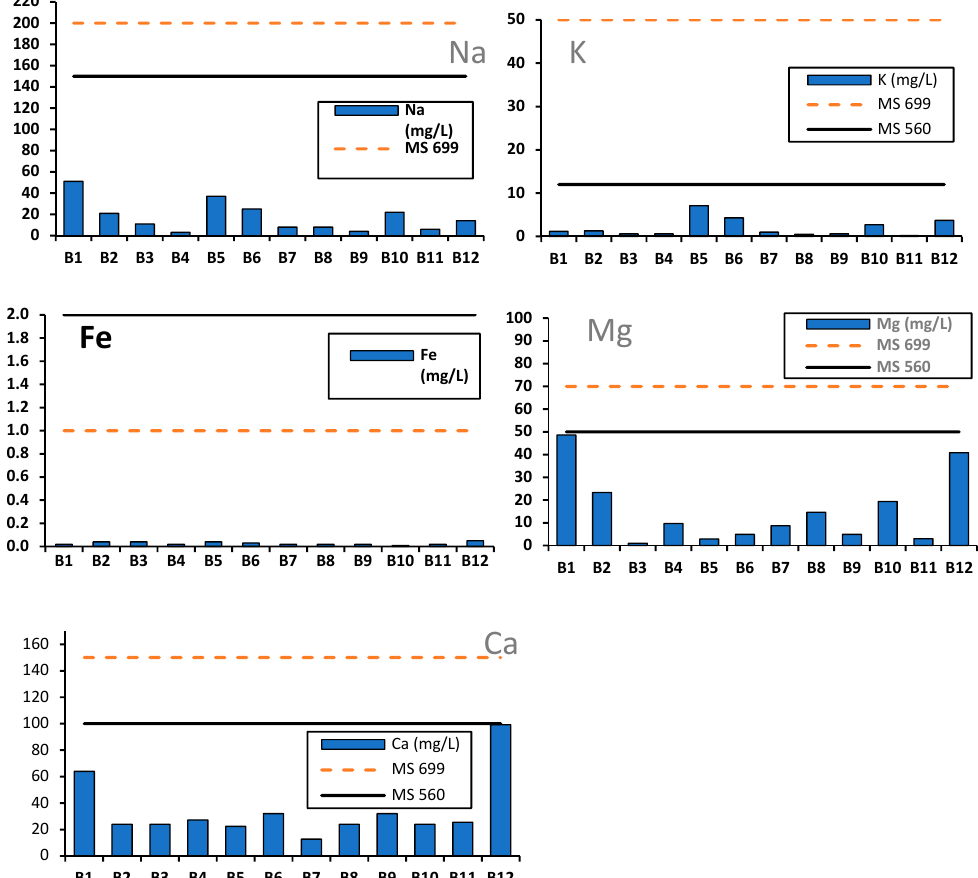
Figure 4. Variations in mineral elements (Na, K, Fe, Ca and Mg) in mg/L for the 12 brands compared to MS 699 (bottled water) and MS 560 (natural mineral water) standards. Data for each brand is the mean values of the total samples ( n = 30).